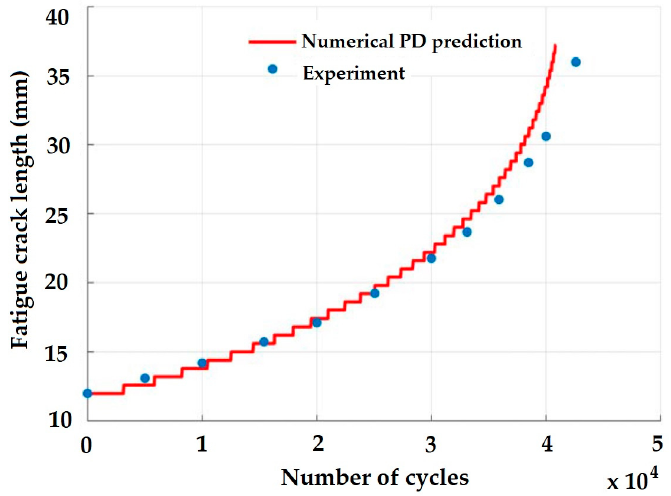
Figure 11. Comparison of PD and experimental data for fatigue crack growth prediction [75].